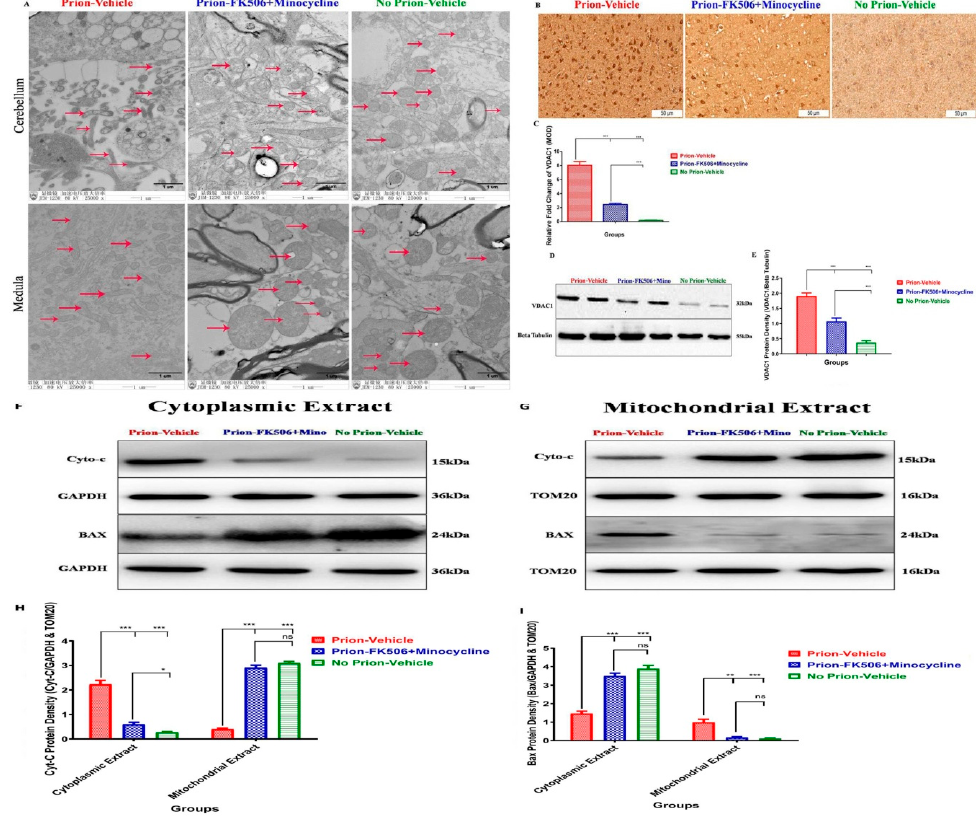
Figure 7. FK506+minocycline treatment reduced mitochondrial dysfunction in prion infected hamsters. ( A ) Representative Transmission Electron microscope images of prion infected and non infected animals. Red arrows represent the mitochondria (80-kV). ( B ) Representative immunohistochemistry slides showing VDAC1 expression in prion infected and non infected animals (scale bar-50 μ m). ( C ) The graphical presentation of 5 animals each per group for VDAC1